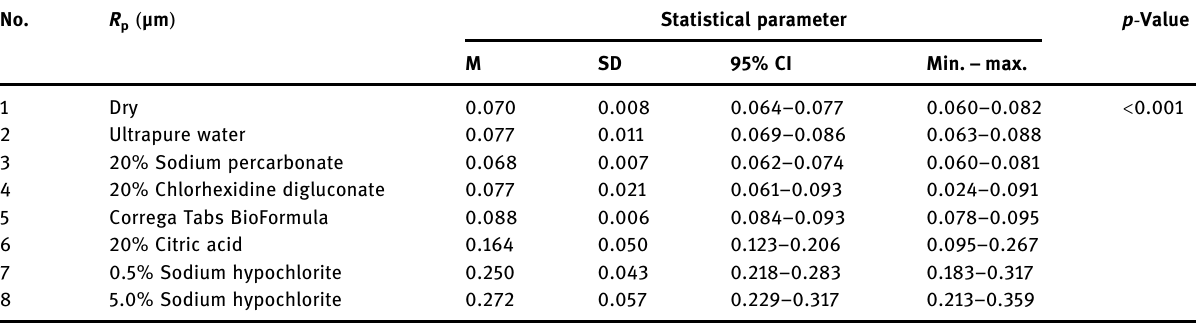
Table 4: Descriptive statistics for R p measurements outcome